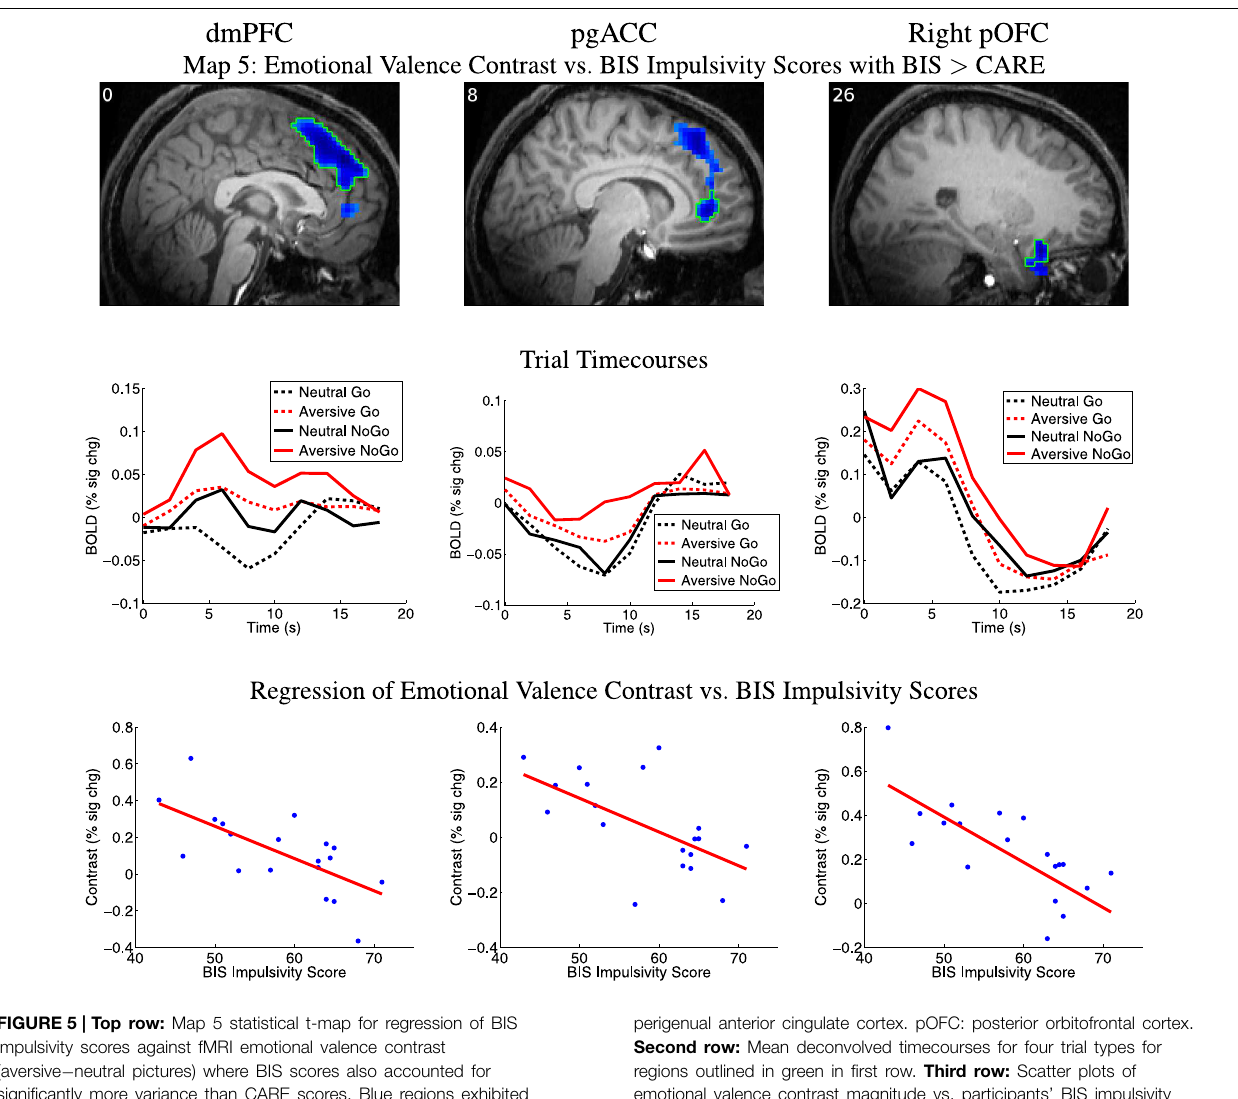
FIGURE 5 | Top row: Map 5 statistical t-map for regression of BIS impulsivity scores against fMRI emotional valence contrast (aversive − neutral pictures) where BIS scores also accounted for significantly more variance than CARE scores. Blue regions exhibited smaller contrast magnitude in participants with higher BIS impulsivity scores. All results p < 0 . 05 (corrected for multiple comparisons). See Section 2.7 for details. t -value color scaling as in Figure 4 . Slice X coordinate in MNI space shown in upper-left. pOFC: posterior orbitofrontal cortex. dmPFC: dorsomedial prefrontal cortex. pgACC: